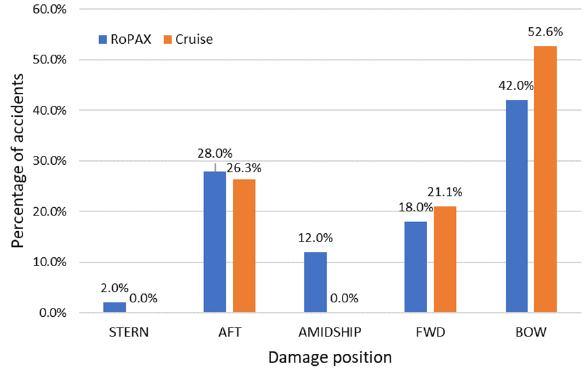
Figure 15 . Longitudinal distribution of damage breaches .